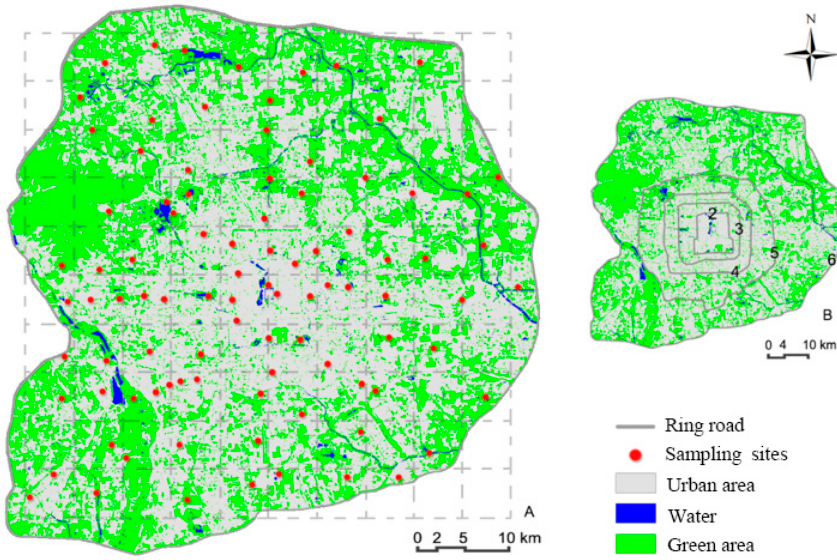
Figure 1. The layout of soil sampling parks ( A ) and the ring road location ( B ).